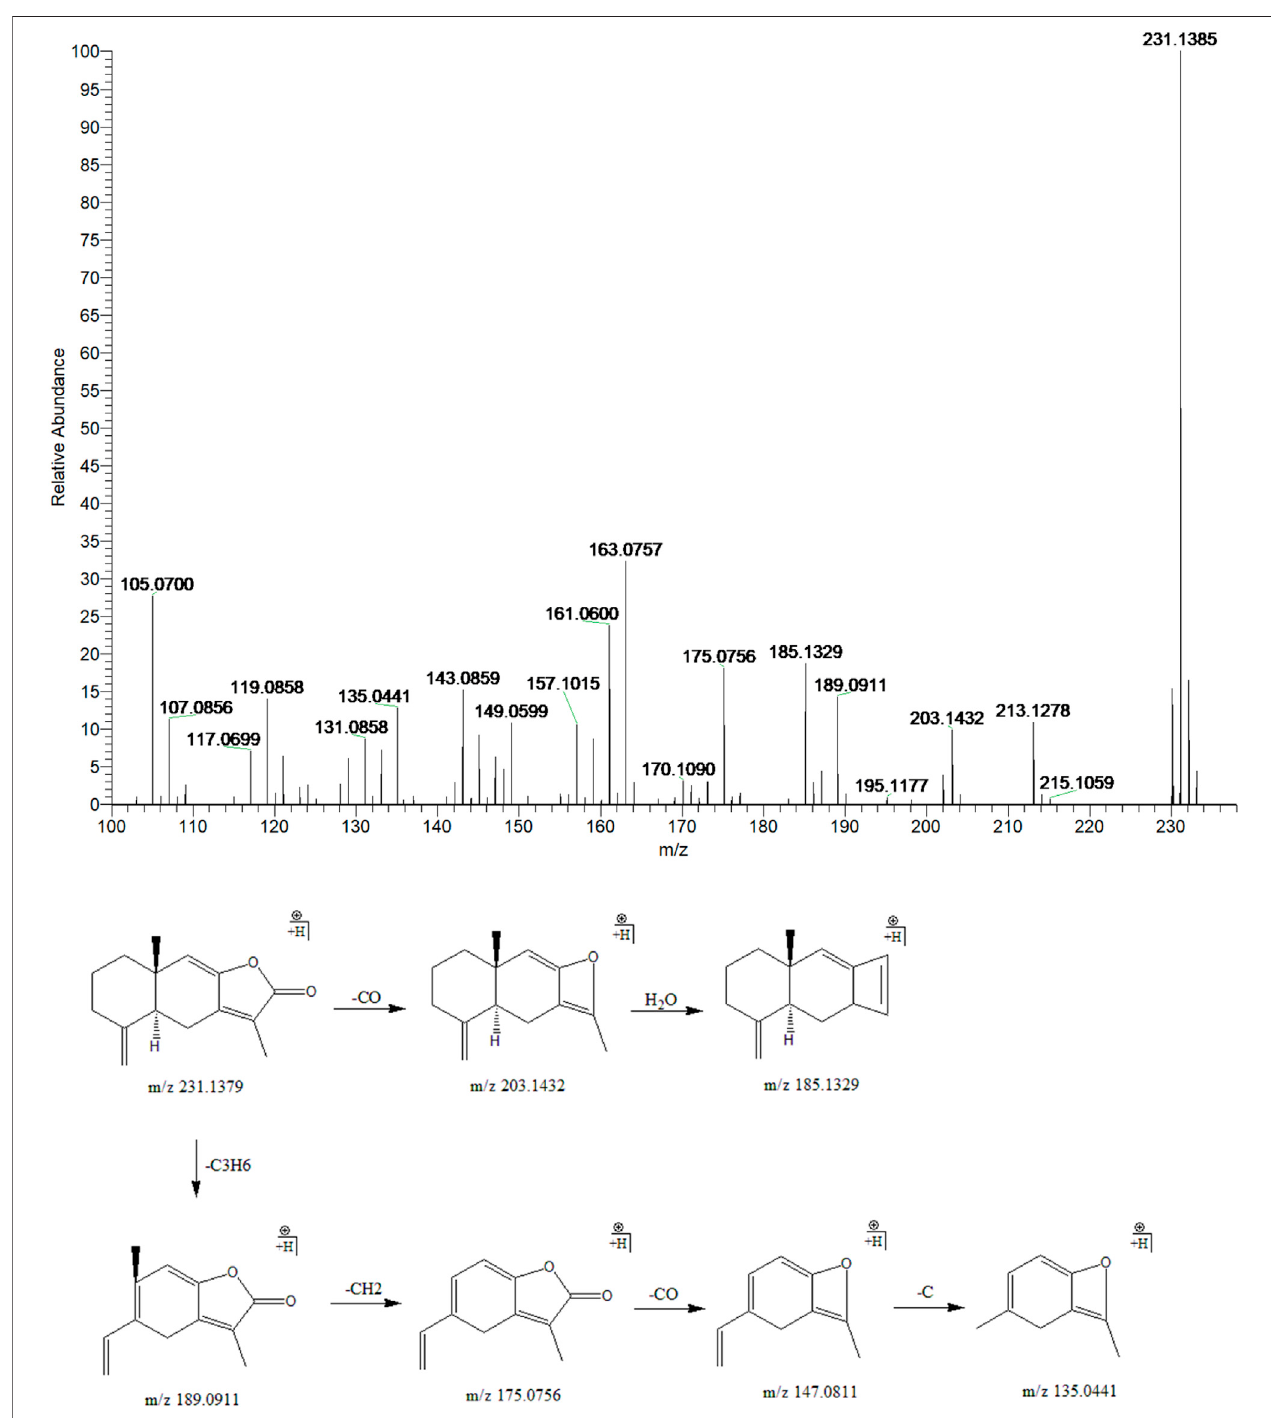
FIGURE 8 | The second-order mass spectrometry graphs and proposed fragmentation pathways of atractylenolide I, II, and III (peaks 3, 4, and 12).